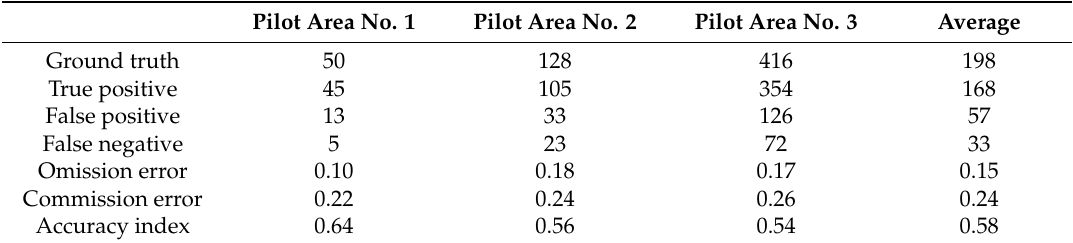
Table 2. Accuracy assessment of the threshold-based method for the three pilot study areas with low, moderate and high complexity,